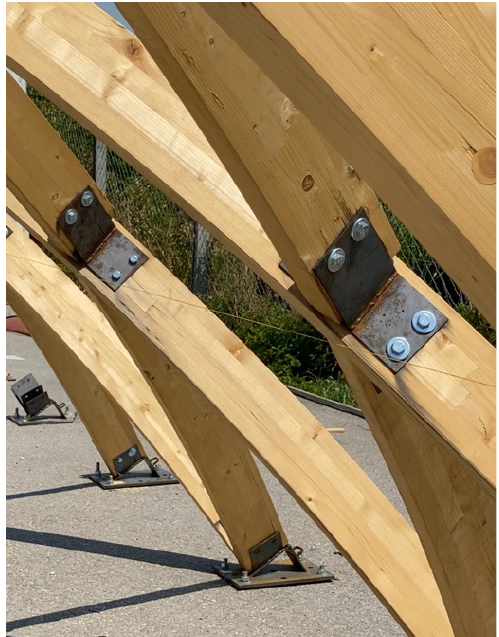
Figure 14. Prototype detail.